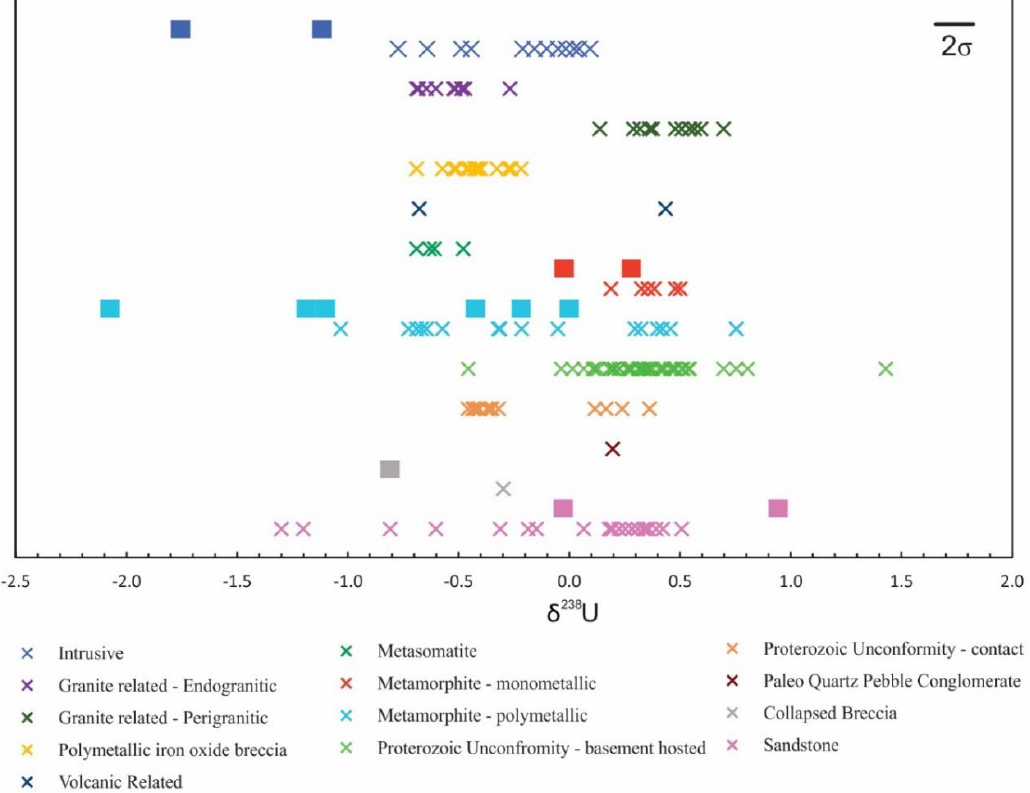
Figure 5. Natural 238 U/ 235 U ratios of uraninite plotted as δ 238 U (defined in text) based on their deposit type. Uraninites from this study (solid squares) and several other previous studies (X symbols), which include: [9,20,25,50,51,59,61,62]. Solid line in upper right corner represents external reproducibility.